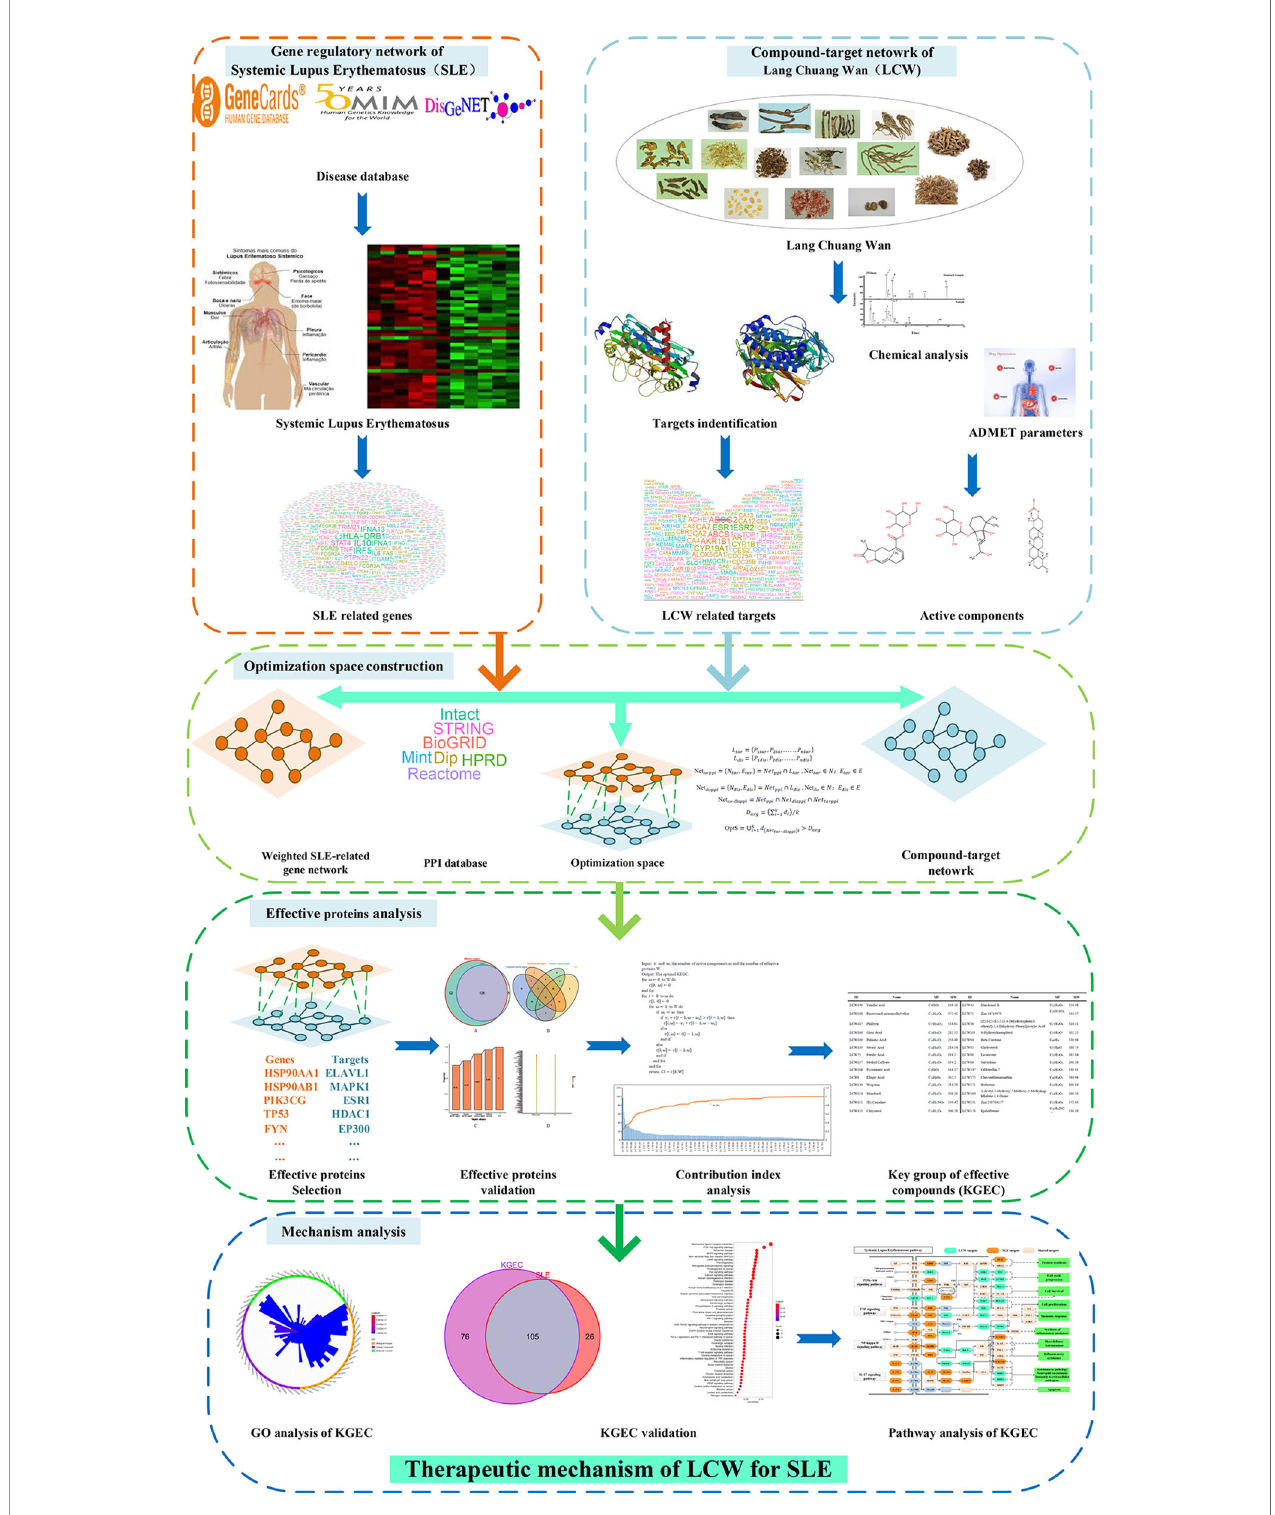
FIGURE 1 | The fl owchart of our proposed network pharmacology approach. Experimental methods include gene regulatory network of SLE, compound-target netowork of LCW, optimization space construction, effective proteins analysis and mechanism analysis. SLE represents systemic lupus erythematosus, LCW represents Lang Chuang Wan, KGEC represents key group of effective